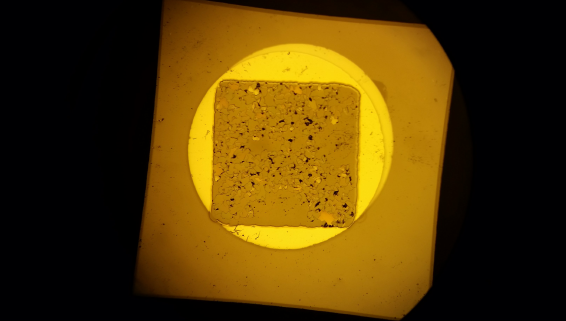
Figure 8. The electrode and the conversion layer at the diamond crystal - second side (first detector)